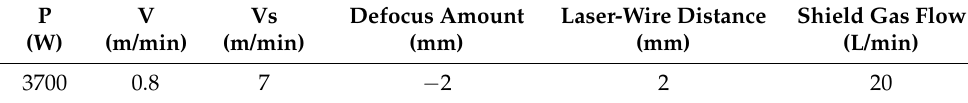
Table 11. Welding process parameters.